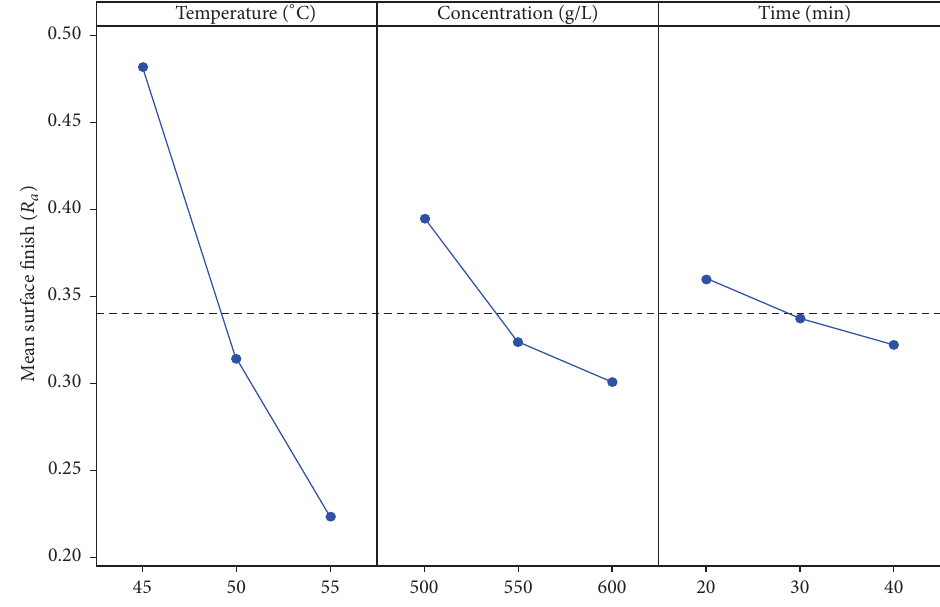
Figure 6: Main effect plot for roughness ( 𝑅 𝑎 ).